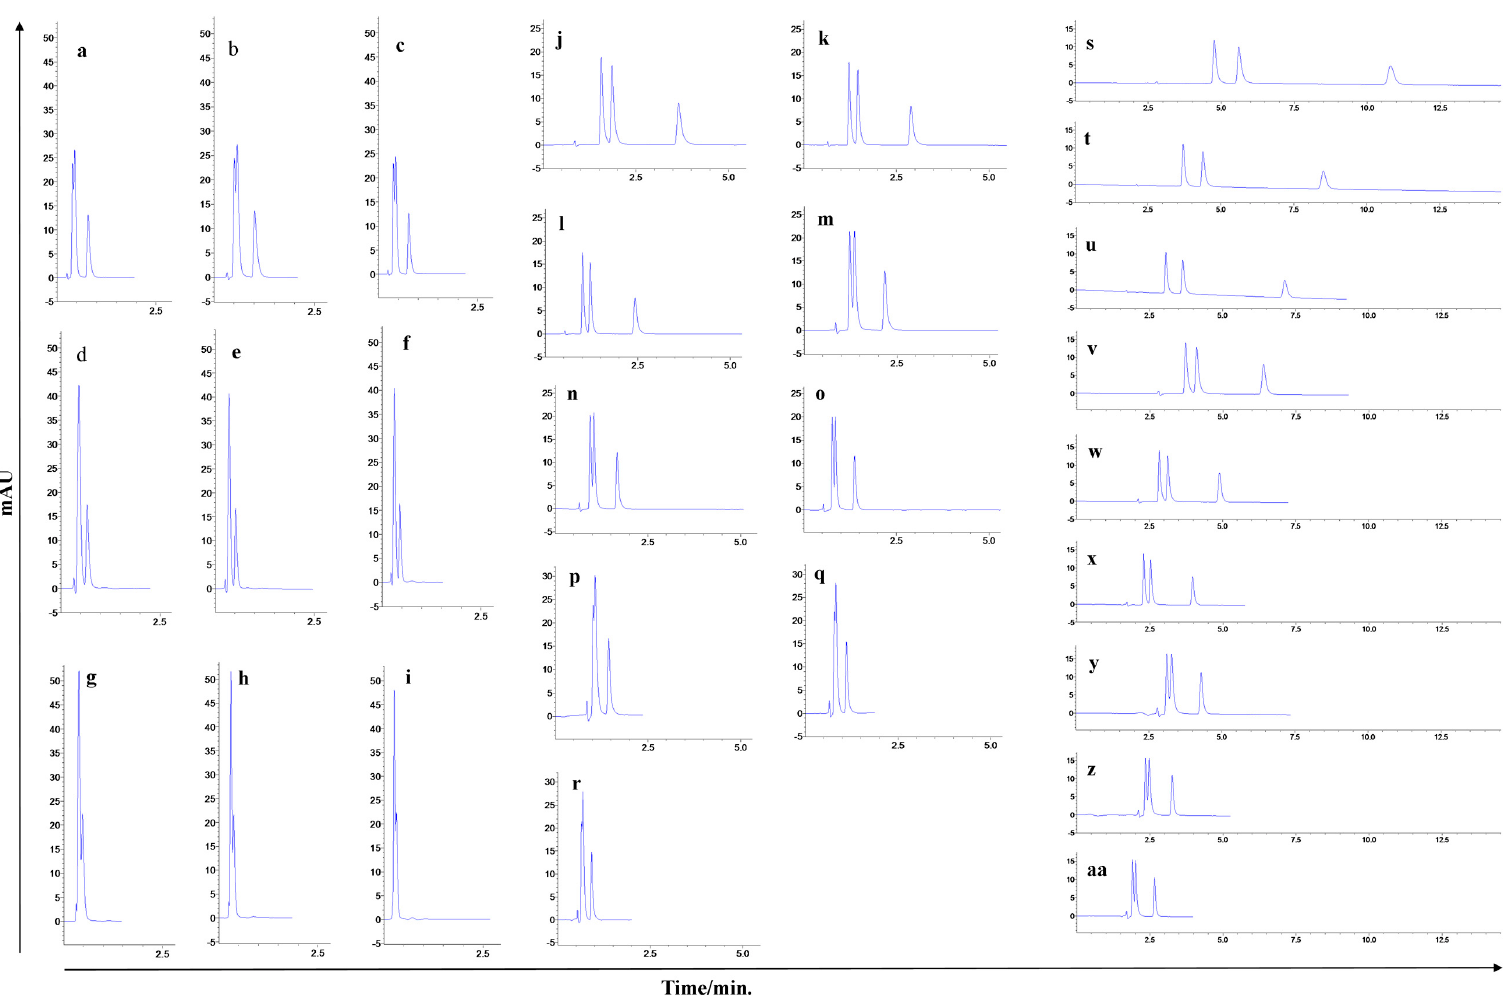
Figure 4. Chromatograms obtained by conditions design of experiments (DoE) approach to development of an UHPLC method with the 30 mm ( a – i ), 50 mm ( j – r ) and 75 mm ( s – aa ) column length. Chromatograms ( a – i ), ( j – r ) and ( s – aa ) are respectively in the same scale.